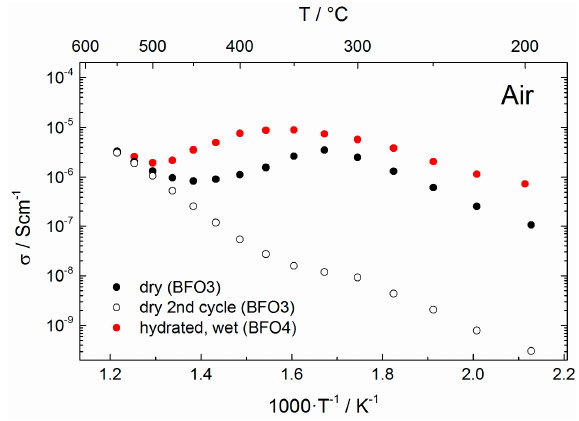
Figure 11. Arrhenius plots (only bulk contribution) for samples measured in dry/wet Air during heating.